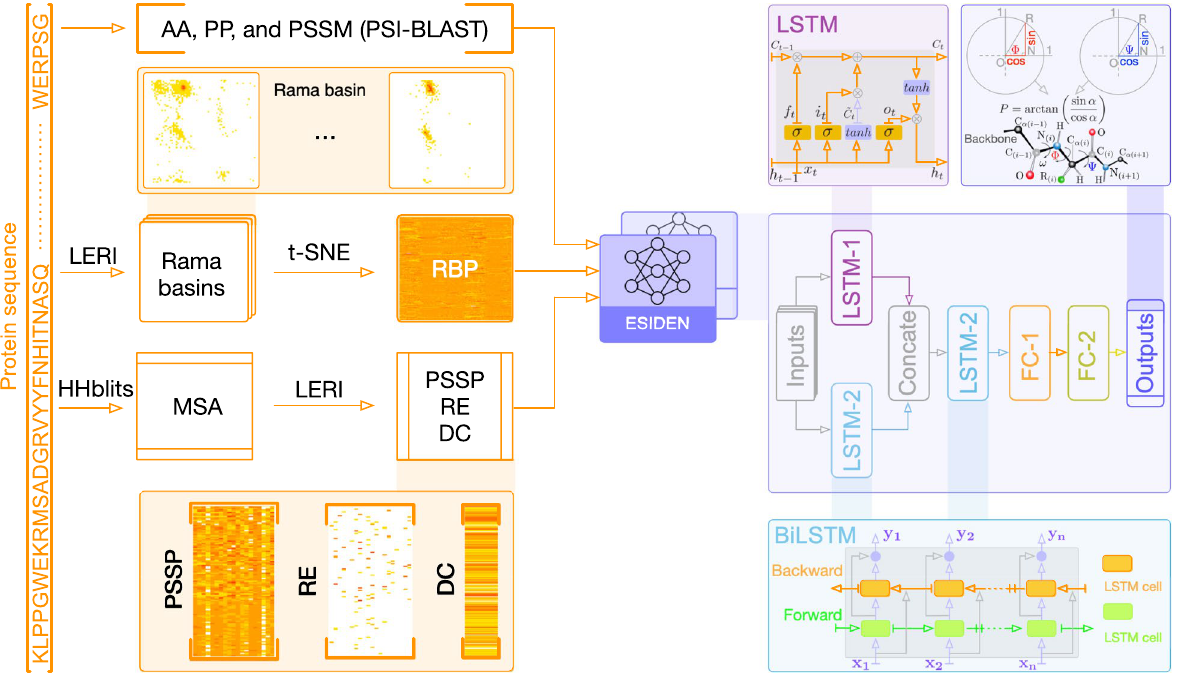
Figure 1. Schematics of prediction system and the ESIDEN network for protein torsion angles. Starting from the primary sequence, the system extracts and processes the features ( L × 232 ) as inputs to feed the ESIDEN network. The ESIDEN mainly composes of LSTM (LSTM-1 is in parallel with LSTM-2 and they are concatenated to another LSTM-2) and FC